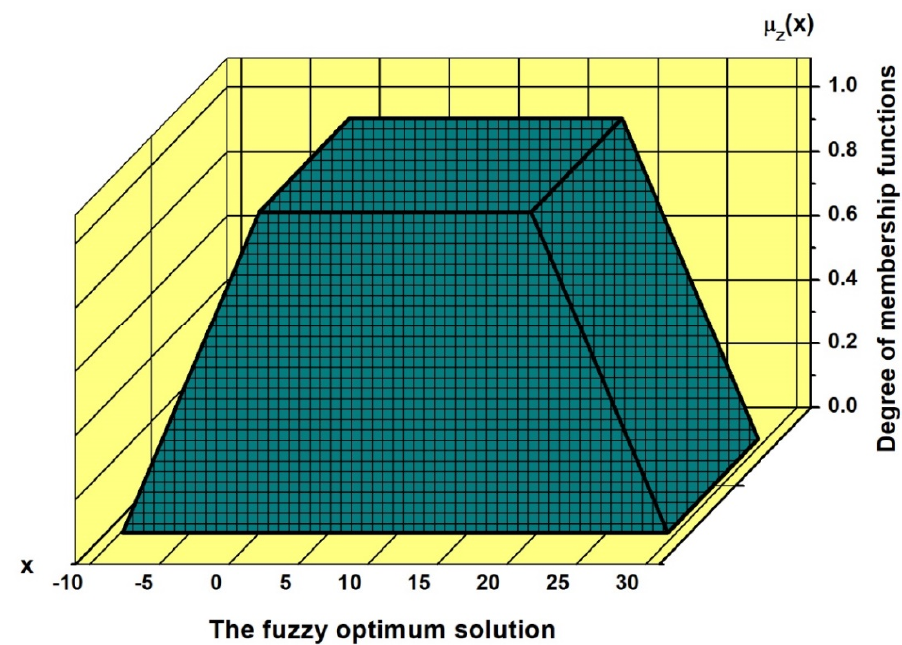
Figure 3. Pictorial representation of fuzzy optimum solution μ Z (x).